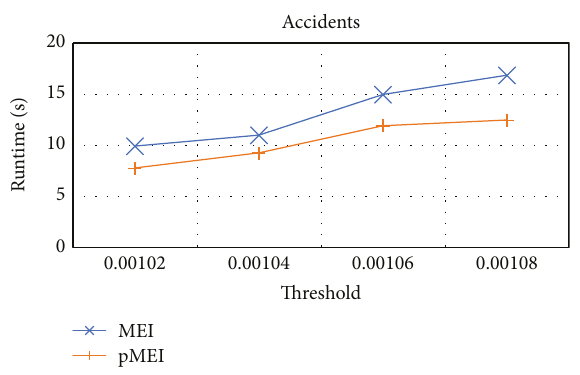
Figure 2: Runtimes of the MEI and pMEI methods on the